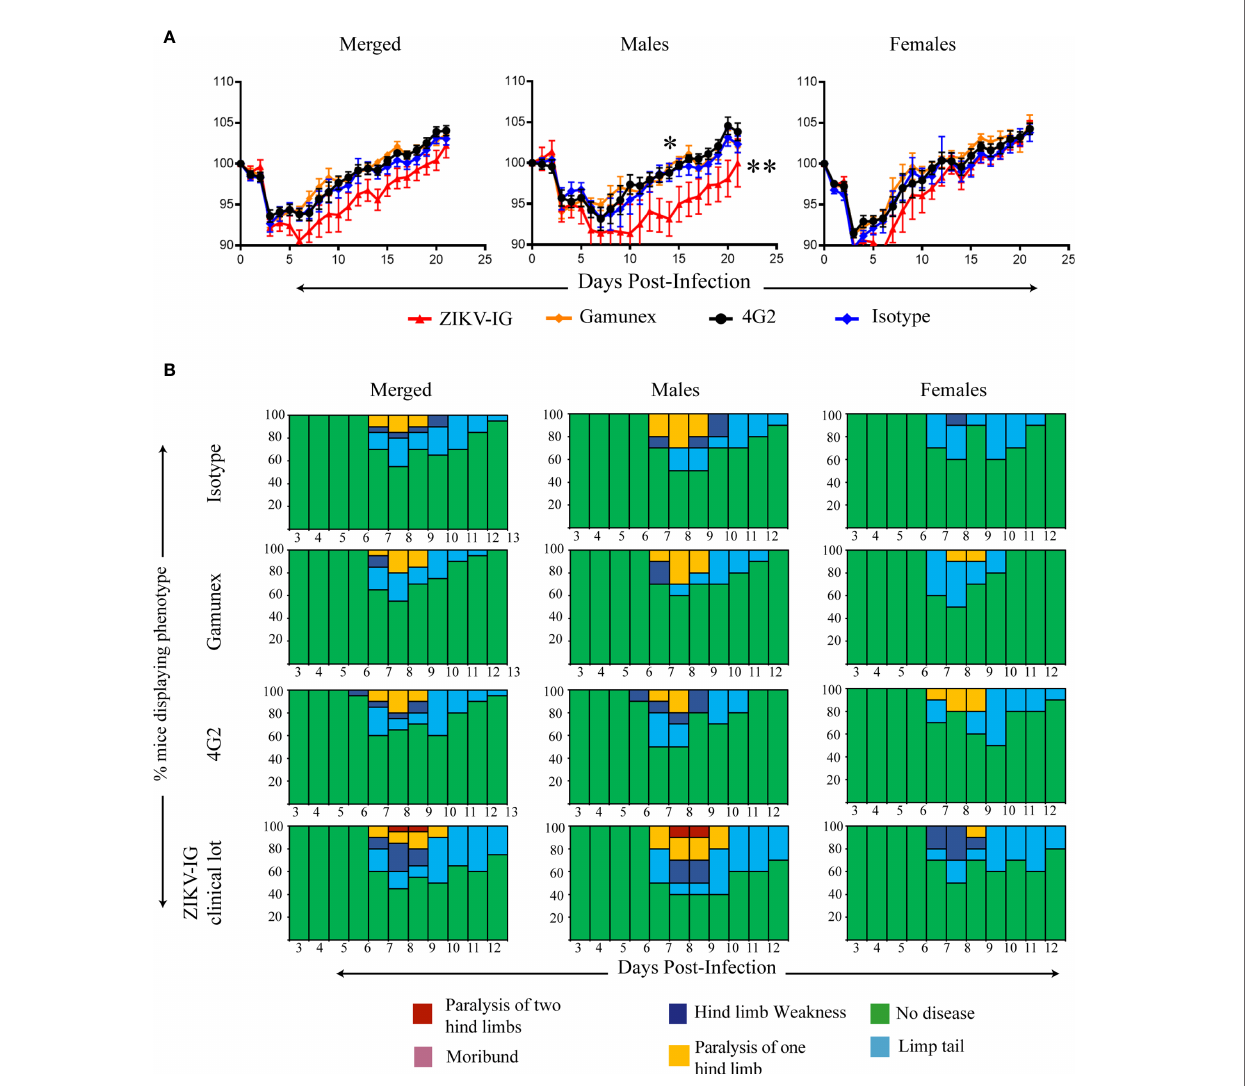
FIGURE 5 | Role of sex differences on weight loss, and clinical score of ZIKV-infected Ifnar1-/- mice under ADE conditions. We separated the data from Figure 4 based upon sex. Weight change (A) and clinical score (B) were monitored. The data re fl ects 10 male and 10 female mice per group. Mice were evaluated for signs of disease daily and graphed on each day as a percentage of mice displaying that disease indicator. Signs of disease range from no apparent disease, limp tail, hind limb weakness, hind limb paralysis, complete paralysis to death. Body weight comparison as single days was completed by Dunnett ’ s test, comparisons of weight over time was completed by 2-way ANOVA, while number of disease days was determined by Fisher exact test. Statistical differences are denoted by a star *p < 0.05, **p <